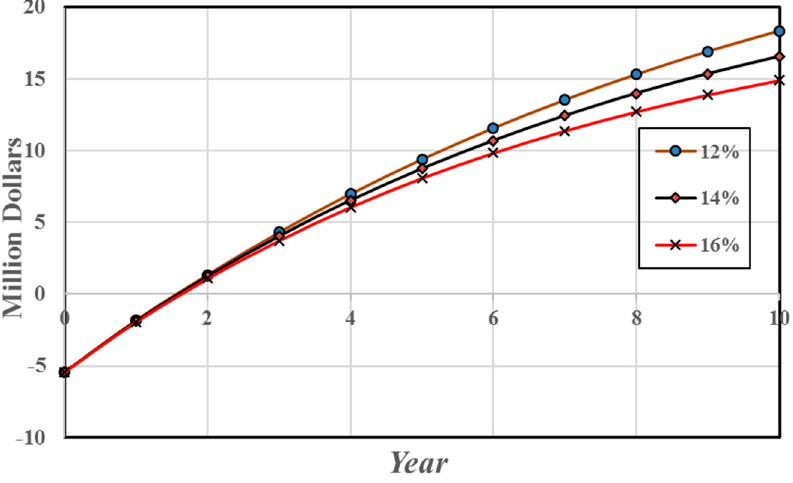
Figure 9. Trend of the sum of the cash flow of the flare recovery system and its payback period (PBP).